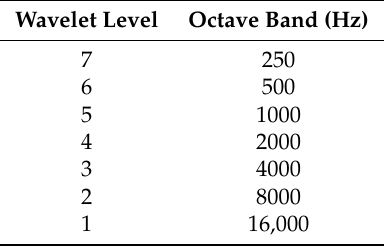
Table 3. Wavelet transform, octave band comparison.